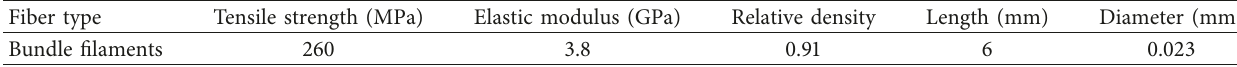
Table 1: Mechanical properties of polypropylene fiber.